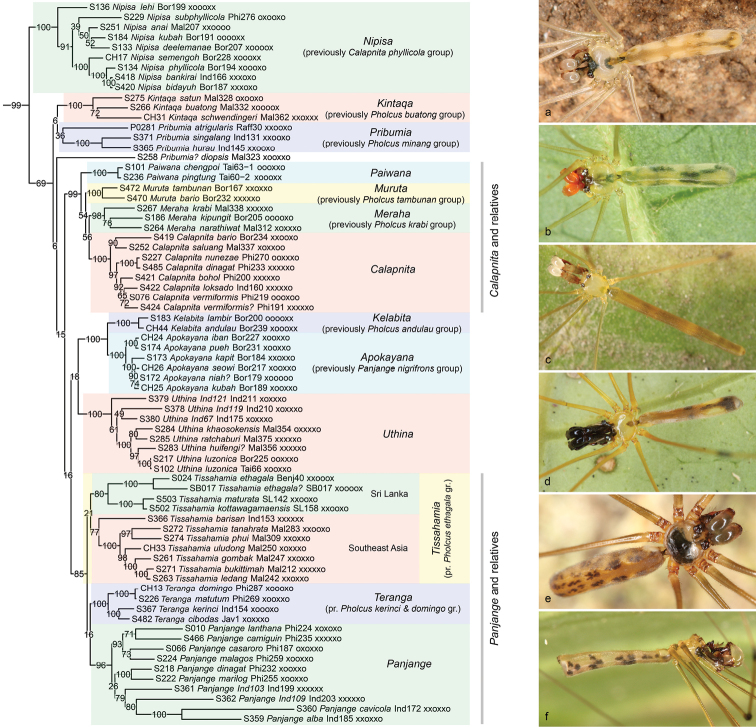
Calapnita-Panjange clade aKintaqasatun (Malaysia) bMerahanarathiwat (Thailand) cCalapnitavermiformis (Philippines) dApokayanakapit (Sarawak) eUthina sp. n. “Ind121” (Indonesia) fPanjangecasaroro (Philippines).